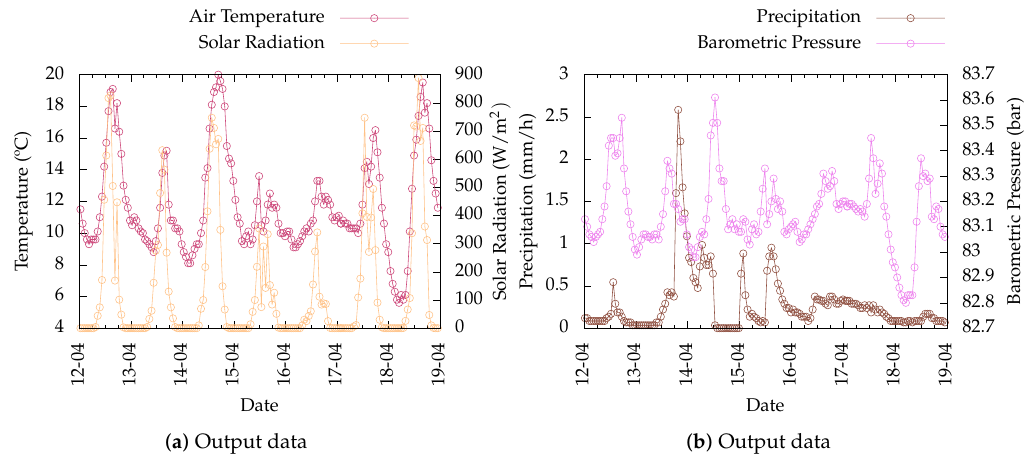
Figure 12. Data from LoRaWAN node with ATMOS41 all-in-one weather station.